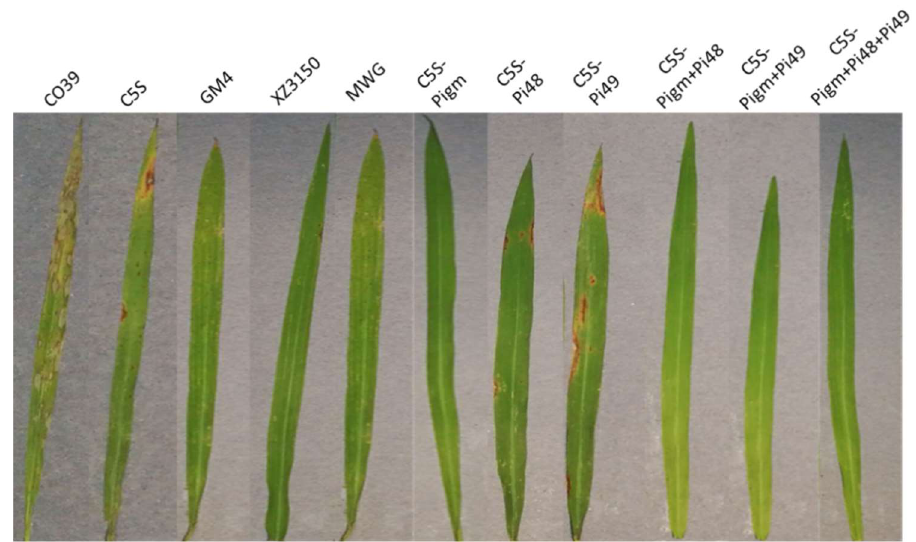
Figure 2. Leaf blast resistance of C5S and the improved lines at seedling stage.